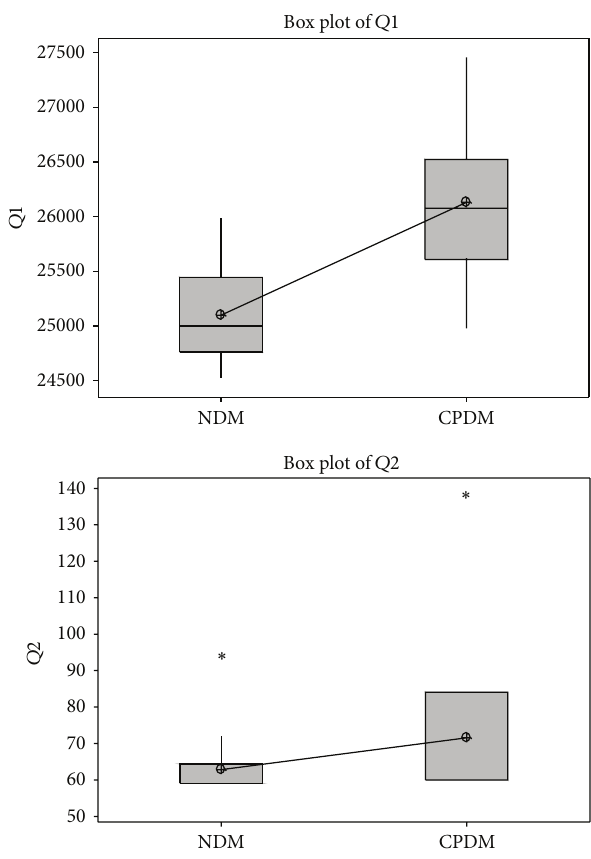
Figure 7: Mean plot of 𝑄1 and 𝑄2 for the NDM and CPDM.